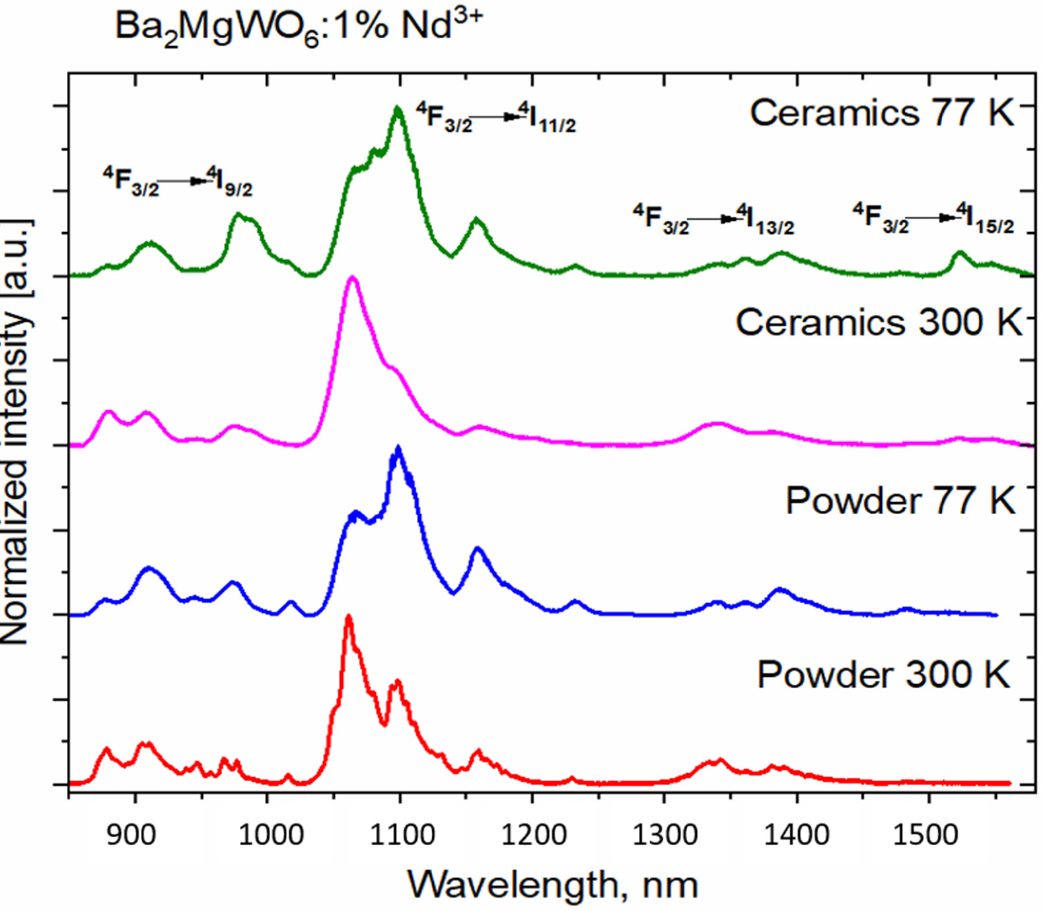
Figure 11. NIR Nd 3+ emission spectra of BMW-Nd powder and ceramic.